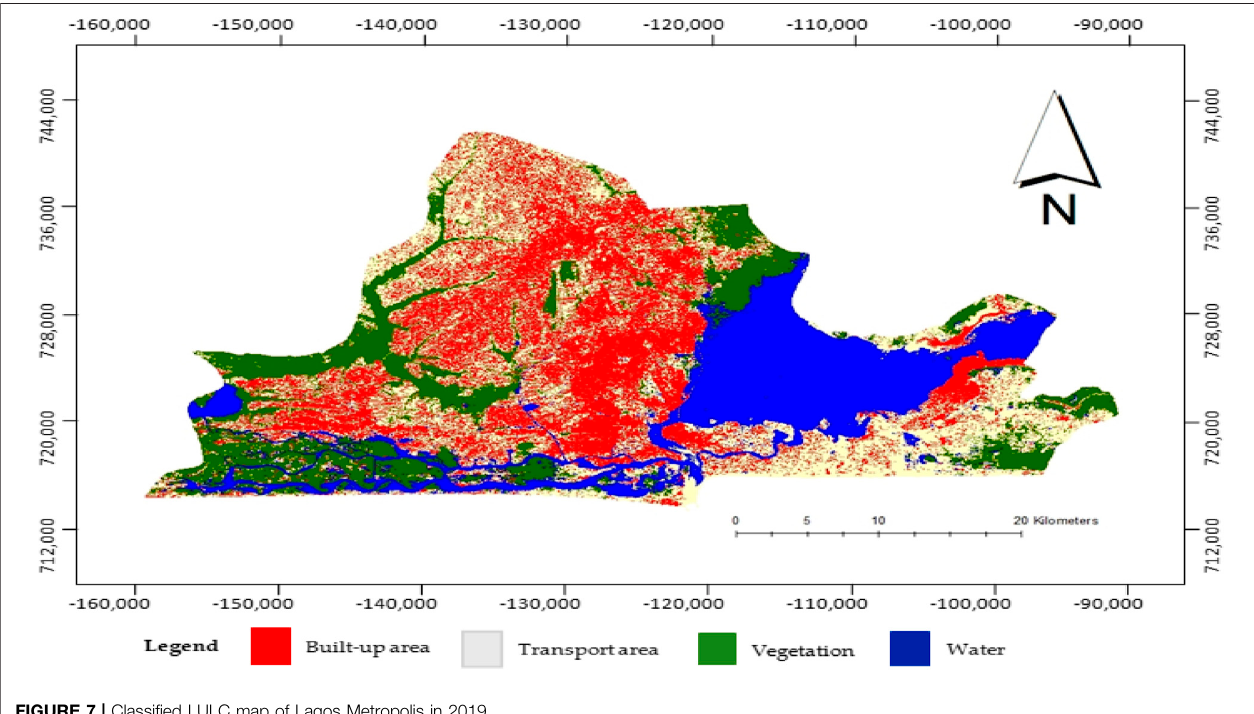
FIGURE 7 | Classi fi ed LULC map of Lagos Metropolis in